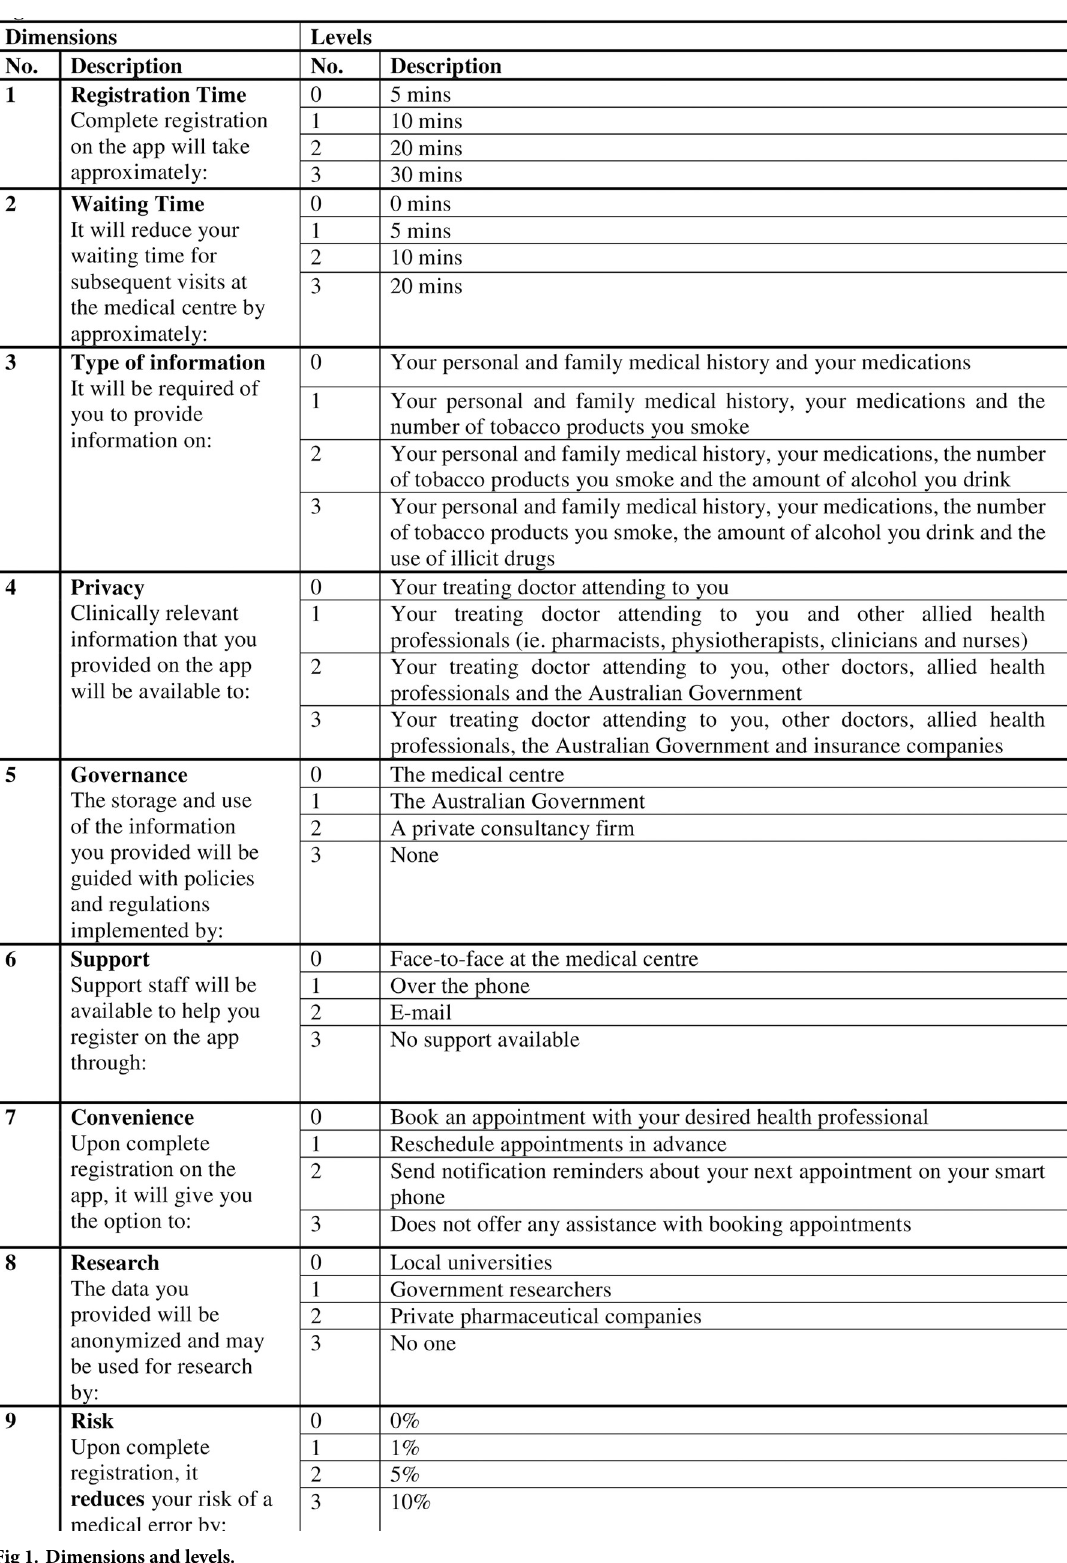
Fig 1. Dimensions and levels.